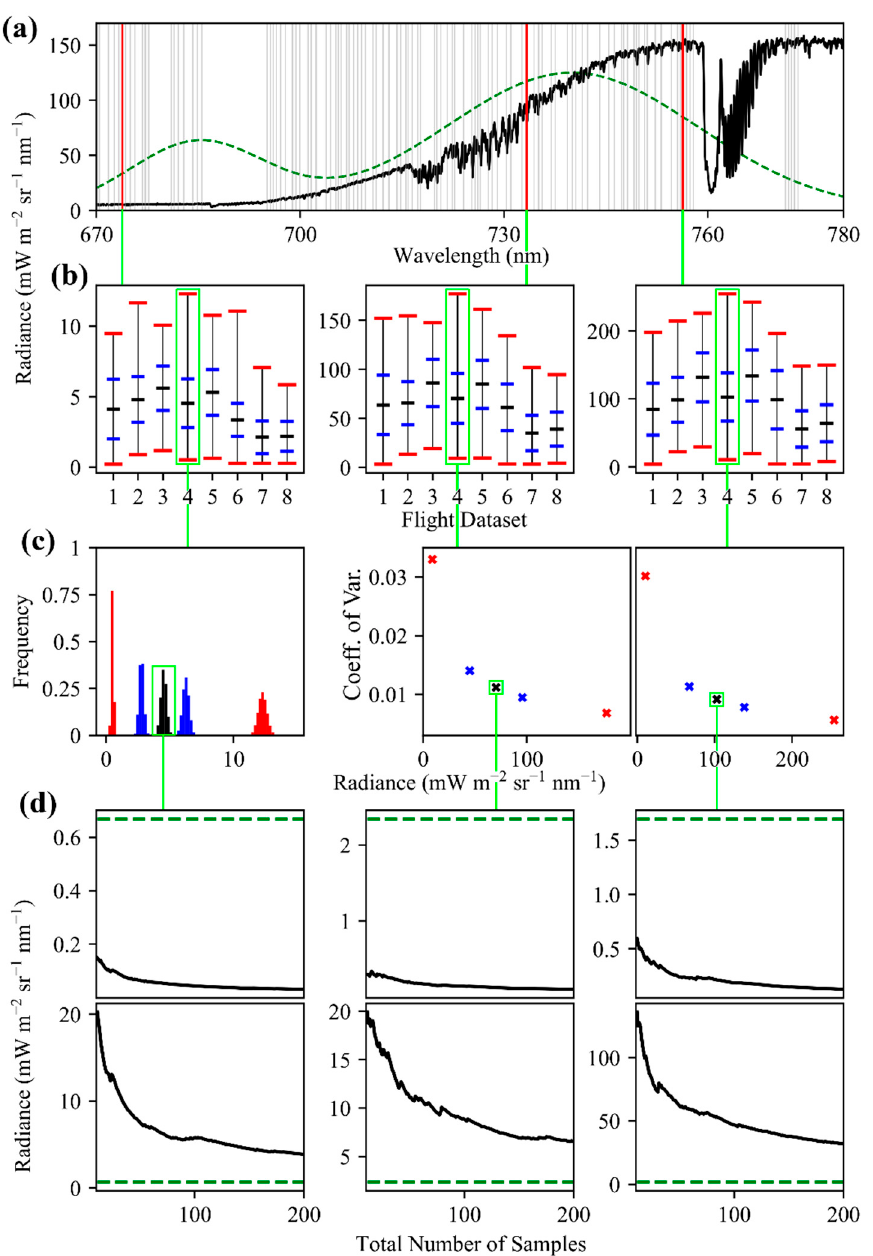
Figure 21. ( a ) Absorption features (gray lines) shown with a FIREFLY vegetation spectra (black line), and a simulated SIF function (green dashed line, not to scale). ( b ) Radiances from in-flight acquisitions (see Appendix A Table A2) for the valley bands of the features shown as red lines in ( a ). The radiance range (vertical black line), mean (horizontal black line), ± one standard deviation (blue lines), and minimum and maximum (red lines) are shown. ( c ) The frequency (left) and coe ffi cient of variation (middle and right) of radiances for Monte Carlo simulation (100,000 samples) of noise distributions centered on the key values of the radiance ranges outlined in green in ( b ). Colors match those of the mean, minimum etc., in ( b ). ( d ) The 95% confidence intervals on the mean for the values outlined in green in ( c ), over the accumulation of samples from the Monte Carlo simulation. Direct retrievals from the valley bands (top row) and indirect retrievals (bottom row) are shown, along with expected SIF radiance (dashed green lines) based on the SIF function in Figure